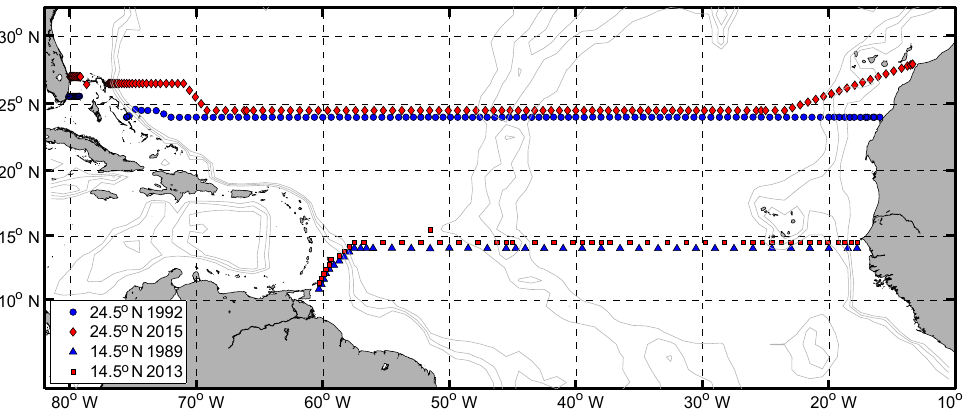
Figure 1. Geographic map showing the hydrographic sections occupied in 1992 and 2015 at 24.5 ◦ N and in 1989 and 2013 at 14.5 ◦ N. Note that only the stations with CTD profiles reaching the bottom are shown here, and that the cruise tracks at both sections are offset by 0.5 ◦ latitude for visual